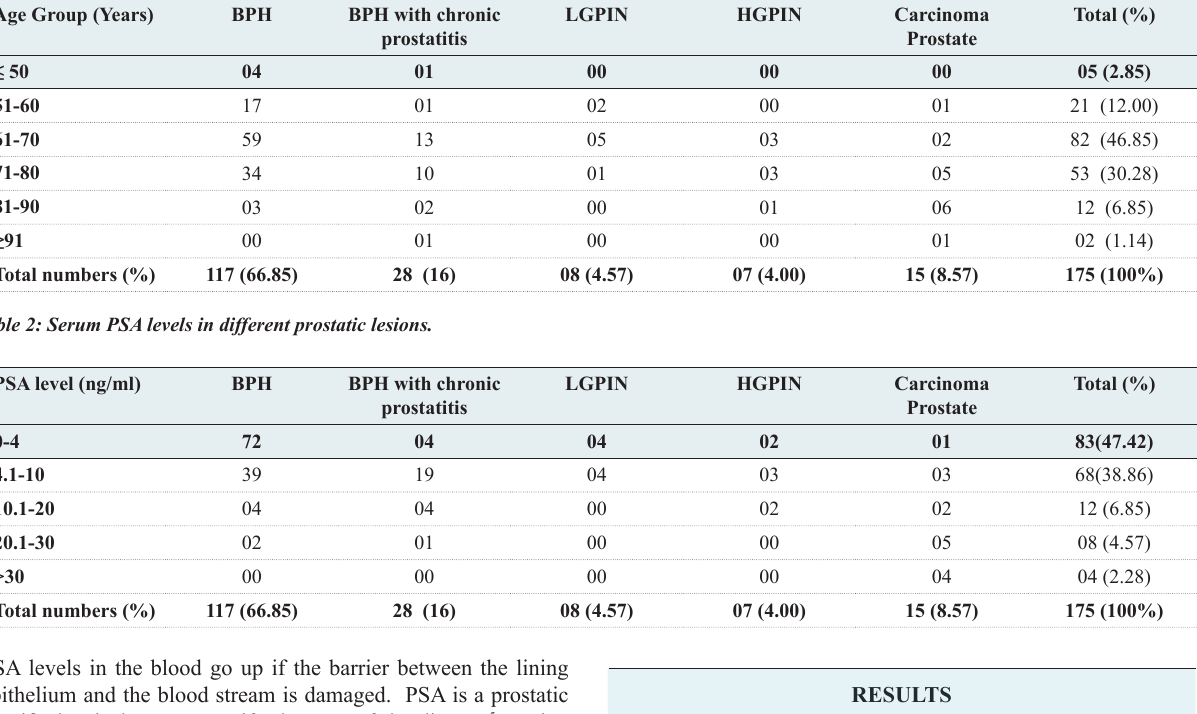
Table 1: Age distribution of patients with different diagnosis of prostatic biopsy